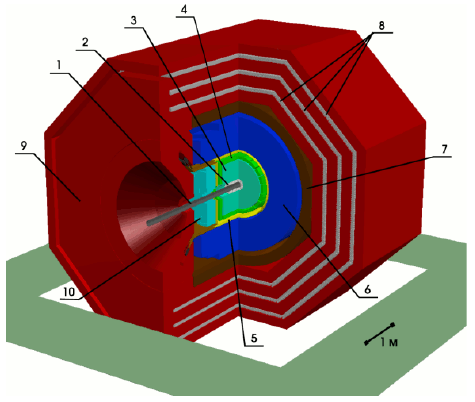
Figure 1. KEDR detector: (1) vacuum chamber, (2) vertex detector, (3) drift chamber, (4) aerogel Cherenkov counters, (5) scintillation counters, (6) LKr calorimeter, (7) superconducting magnet, (8) muon system, (9) magnet yoke, (10) CsI endcap